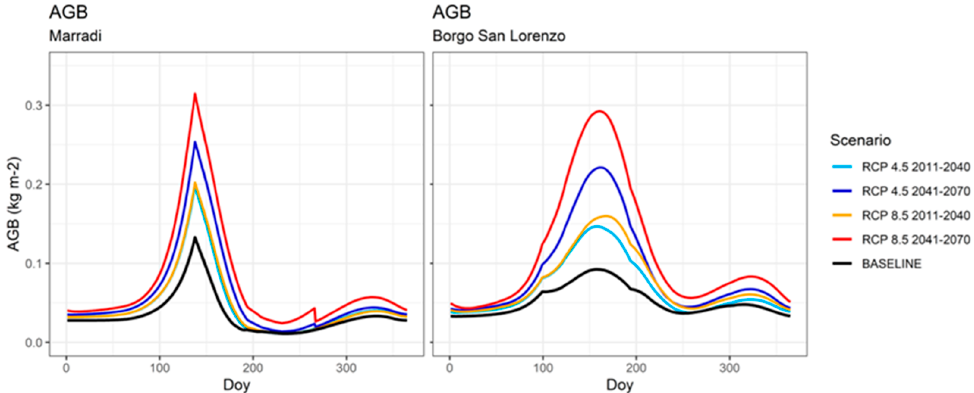
Figure 6. Daily simulation (30-year mean) of aboveground biomass (AGB) with PaSim for baseline and climate change scenarios under business-as-usual management at both study sites.